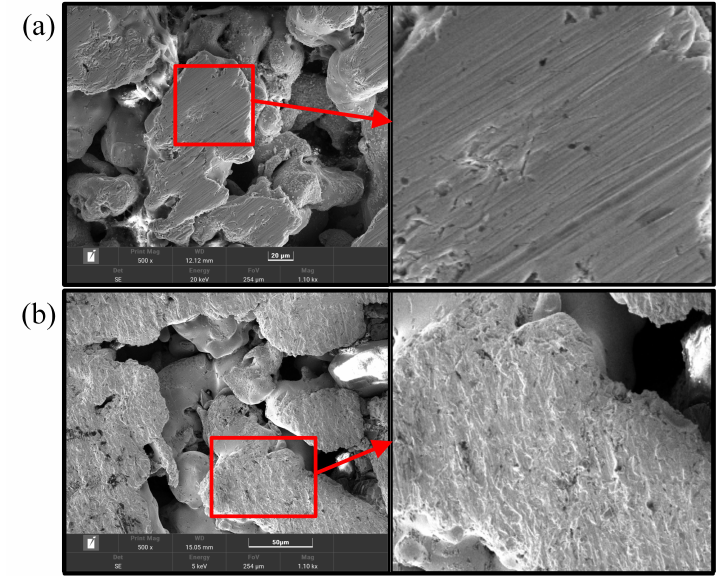
Figure 4. SEM of the CCC: ( a ) Before wettability modification; ( b ) After wettability